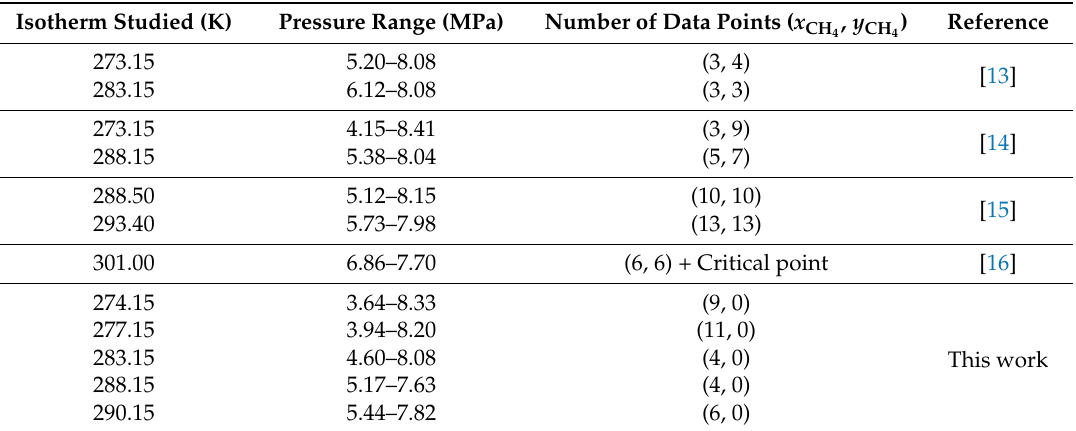
Table 1. Experimental data for the CH 4 -CO 2 binary system at vapour-liquid equilibrium (VLE), between 273.15 and 301 K.